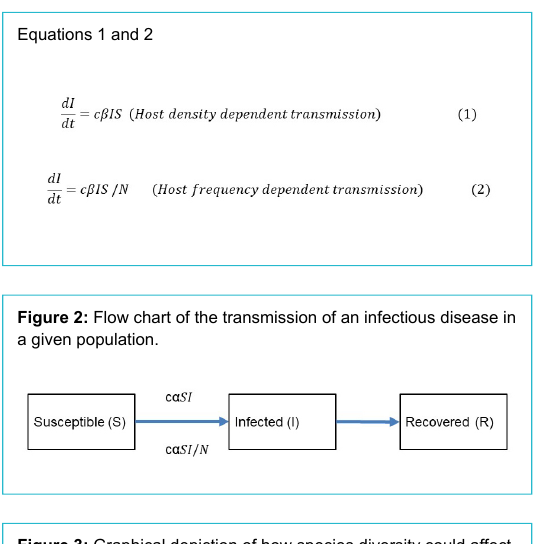
Figure 3: Graphical depiction of how species diversity could affect transmission and prevalence of a directly transmitted disease (adapted from Luis et al.